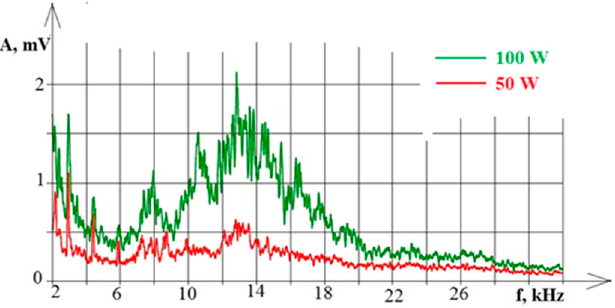
Figure 11. The changes in the effective amplitude of the VA signal in the frequency bands of 0.4–6 kHz (red), 10–20 kHz (blue), and their ratio K f (black) with changes in the speed (V) of the laser beam. Figure 12. VA signals during laser sintering with the same speed and different laser power output: (1)—100 W, (2)—50 W.